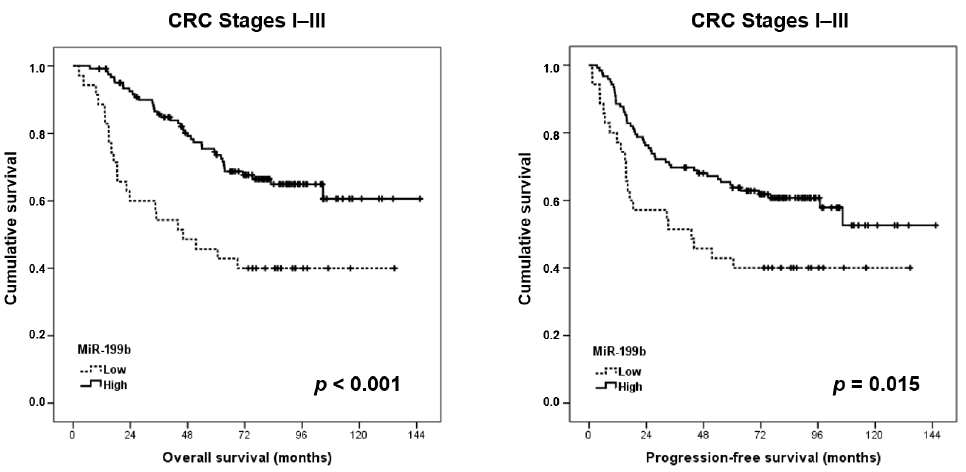
Figure 1. Survival analyses using Kaplan–Meier plots for miR-199b expression in early-stage CRC patients, showing both the overall survival and progression-free survival. CRC, colorectal cancer.